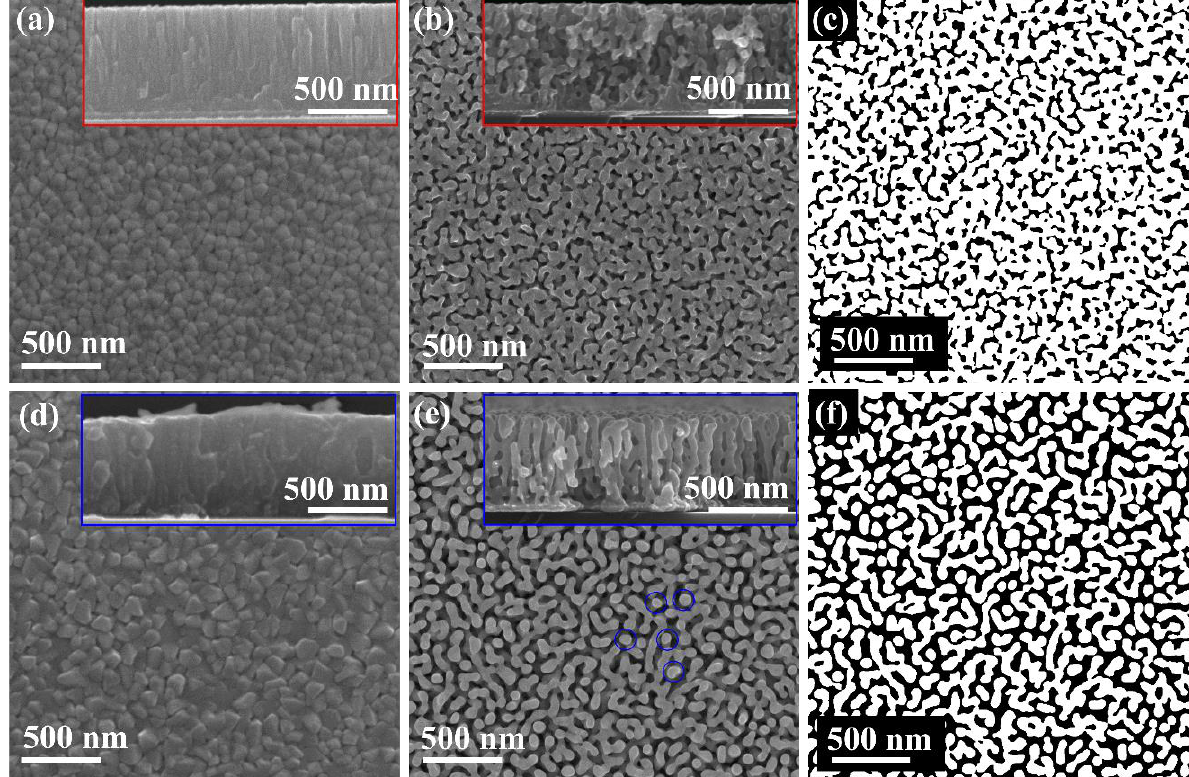
Figure 2. SEM results of the as-deposited Cu – Al and Ag – Al precursor films and the as-dealloyed NP – Cu and NP – Ag Figure 2. SEM images of the as-deposited Cu-Al and Ag-Al precursor films and the as-dealloyed NP-Cu and NP-Ag films. Plan-view of the as-deposited ( a ) Cu 30 Al 70 and ( d ) Ag 30 Al 70 film. Plan-view of the as-dealloyed ( b ) NP – Cu and ( e ) films. Plan-view SEM images of the as-deposited ( a ) Cu 30 Al 70 and ( d ) Ag 30 Al 70 film. Plan-view SEM images of the as- NP – Ag films. ( c ) and ( f ) are the bright and dark segmentation mask images generated by ( b ) and ( e ) read by AQUAMI dealloyed ( b ) NP-Cu and ( e ) NP-Ag films. ( c , f ) are the bright and dark segmentation mask images generated by ( b , e ) read software, respectively. The insets in ( a , b , d and e ) are the corresponding cross-sectional of films. by AQUAMI software, respectively. The insets in ( a , b , d , e ) are the corresponding cross-sectional SEM images of